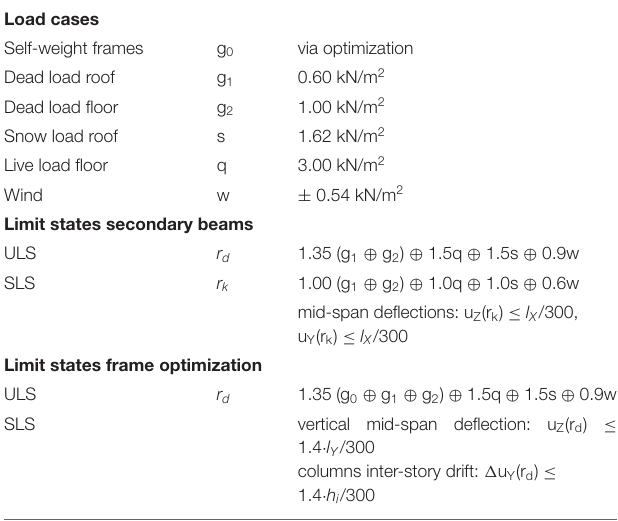
TABLE 4 | Load cases and combinations.